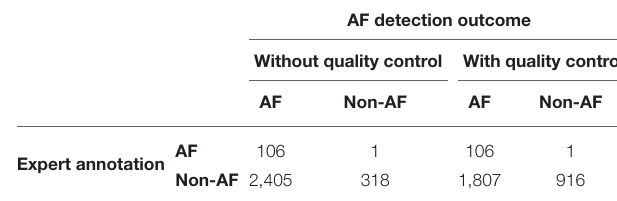
TABLE 7 | Confusion matrix for AF detection with and without quality